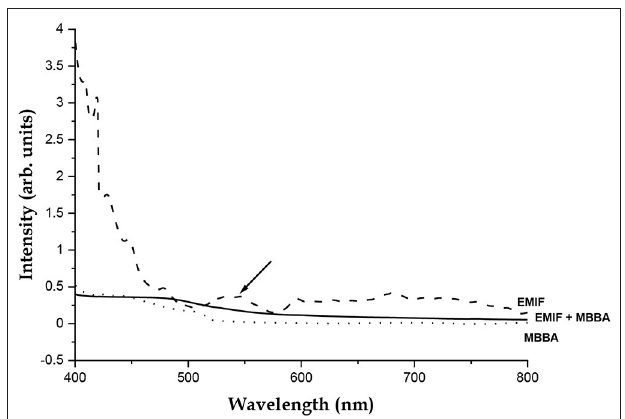
FIGURE 6 | Ultraviolet-Visible Spectrum of EMIF (dashed line), MBBA (dotted line) and the MBBA-EMIF mixture used (solid line). The 6 A 1 → 4 A 4 1, E transition band at 536.68nm is marked with an arrow. This transition is seen to be quenched in the mixture.